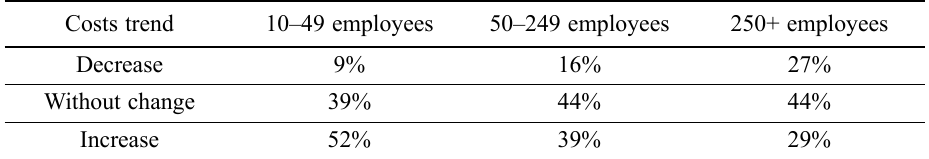
Table 3. Matrix of mutual relationships between dimensions and